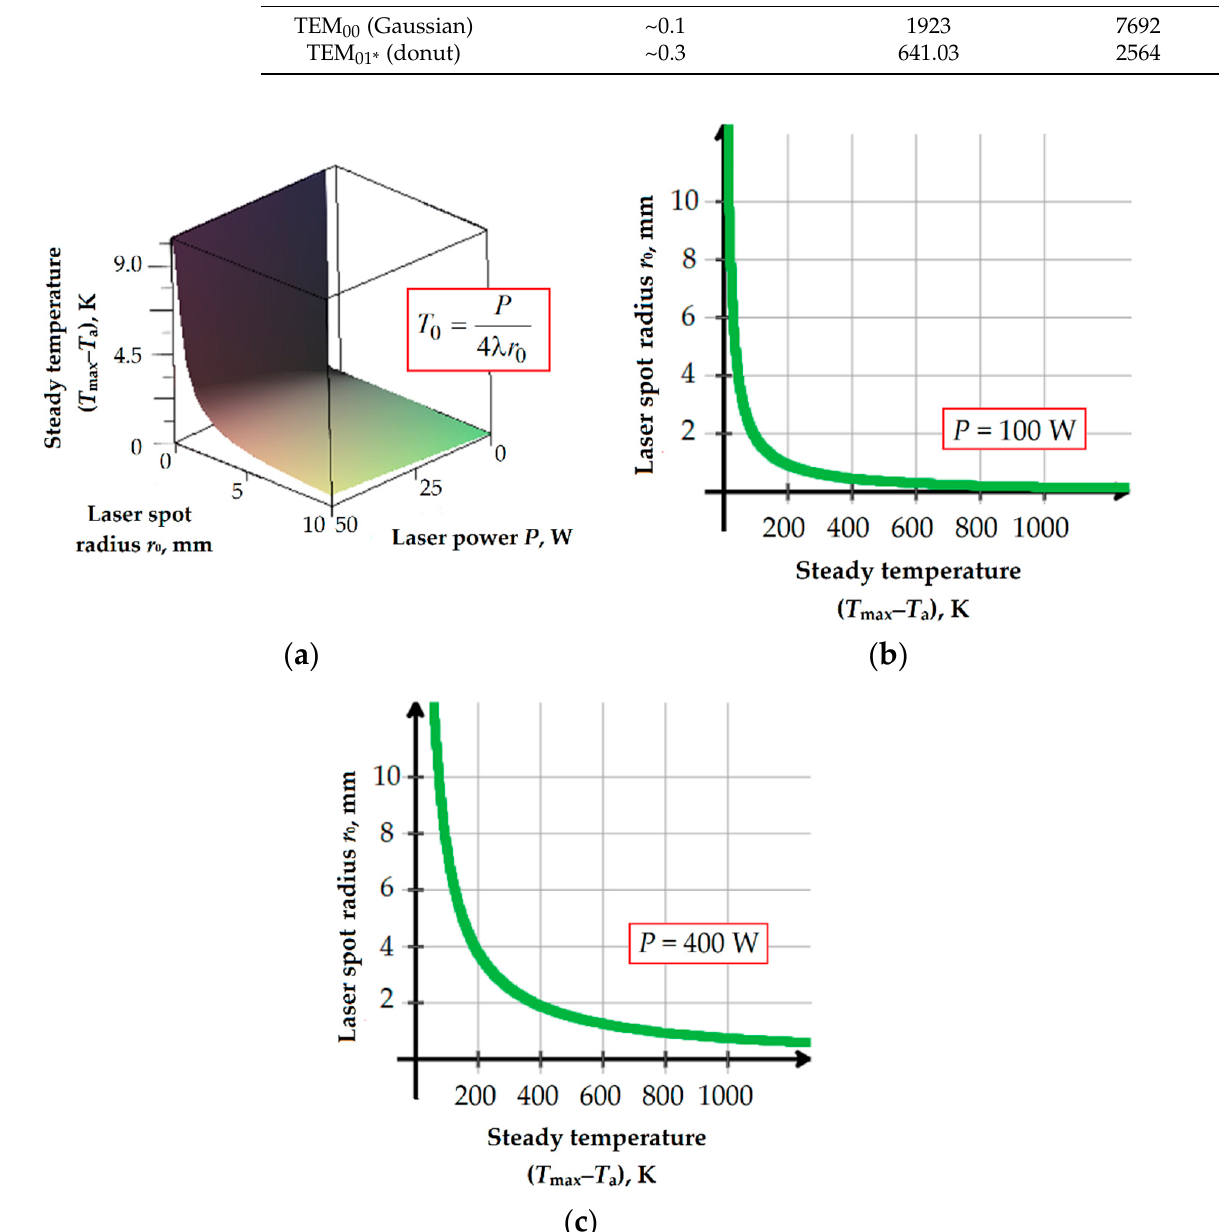
Figure 7. Implicit graphs of the function of temperature ( T max − T a ) on the radius depending on the power of laser radiation for λ = 13 W/(m·K): ( a ) 3D-plot; ( b ) P = 100 W; ( c ) P = 400 W.